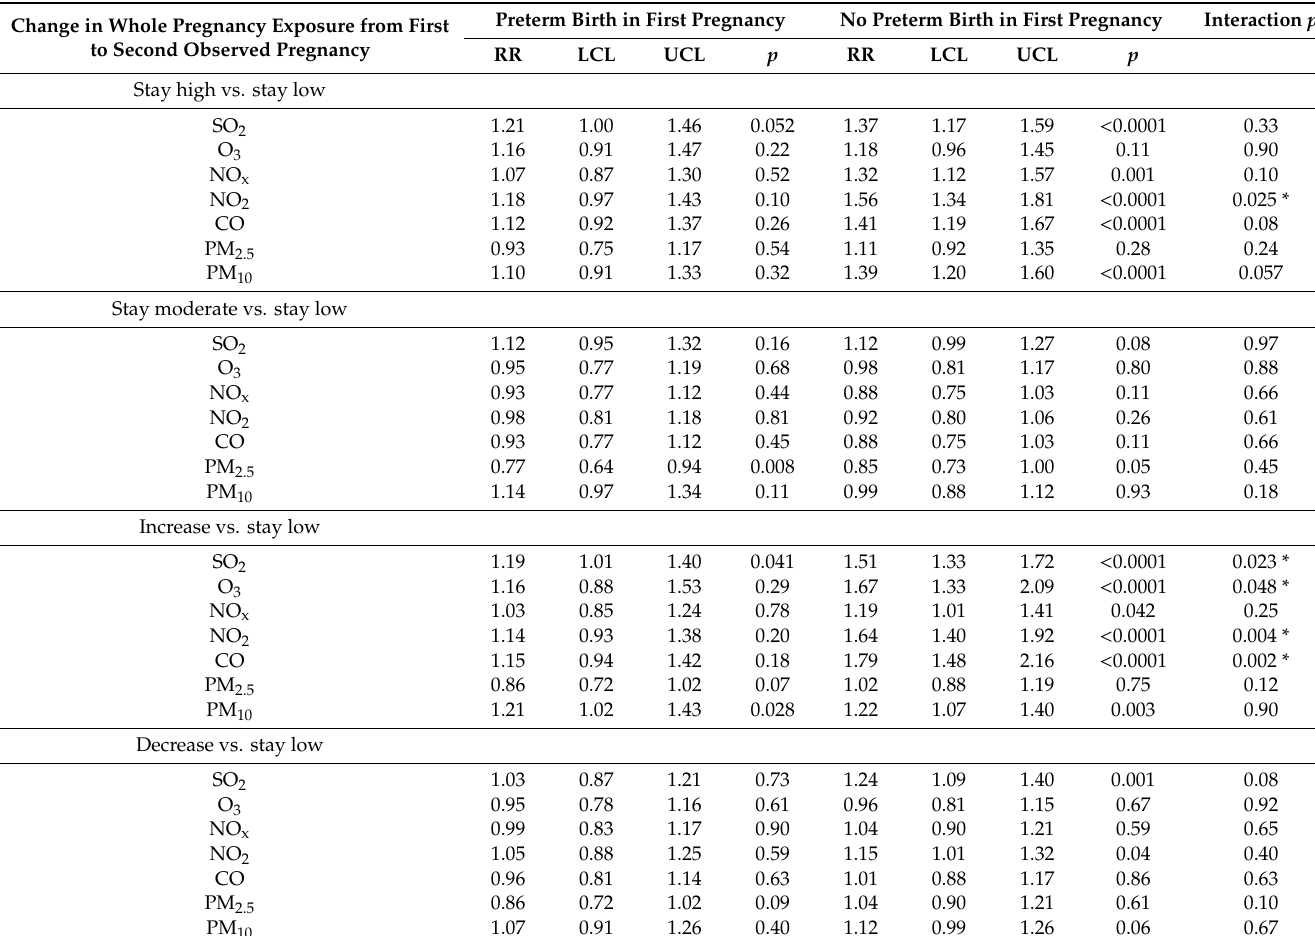
Table 3. The adjusted relative risk of preterm birth in second pregnancy by change in whole pregnancy average criteria pollutant exposure levels from first to second pregnancy by prior preterm birth status among 50,005 mothers, NICHD Consecutive Pregnancy Study, 2002–2010. Change in Whole Pregnancy Exposure from First to Second Observed